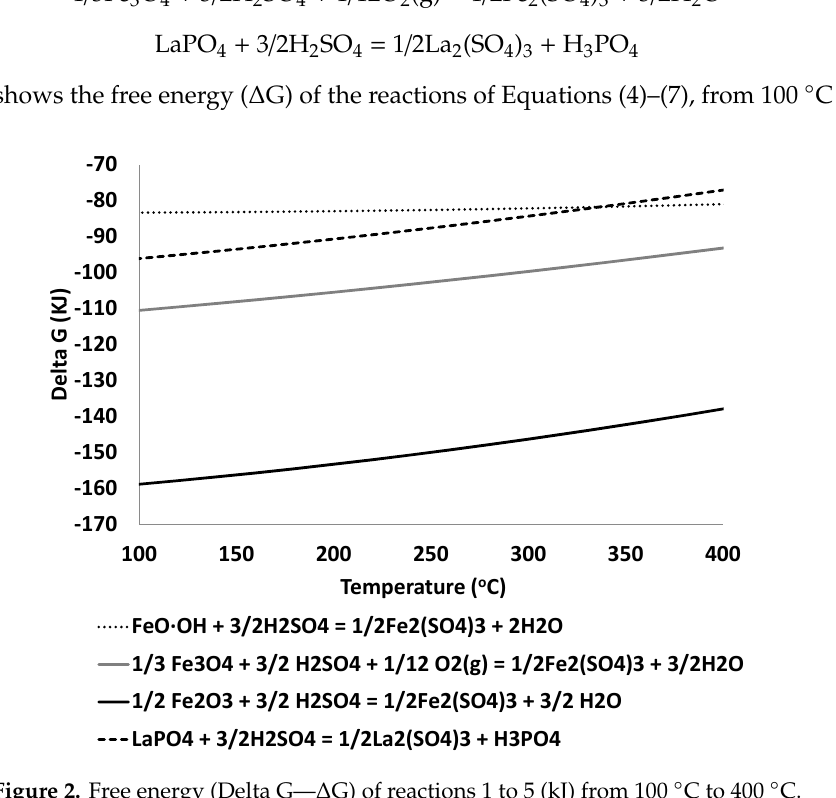
Figure 2. Free energy (Delta G— Δ G) of reactions 1 to 5 (kJ) from 100 °C to 400 °C.